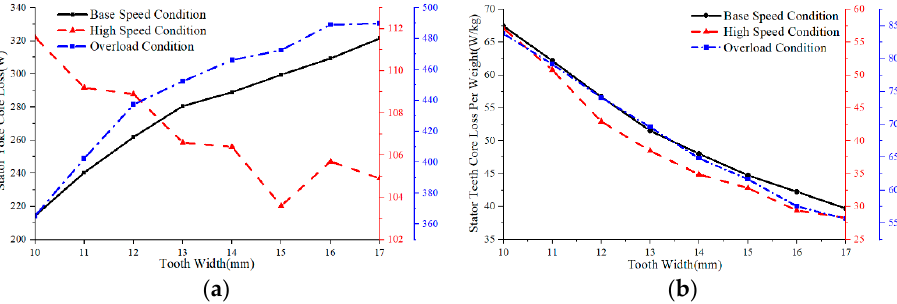
Figure 16. Stator core loss under different tooth widths: ( a ) stator yoke core loss, ( b ) stator teeth core loss per weight.